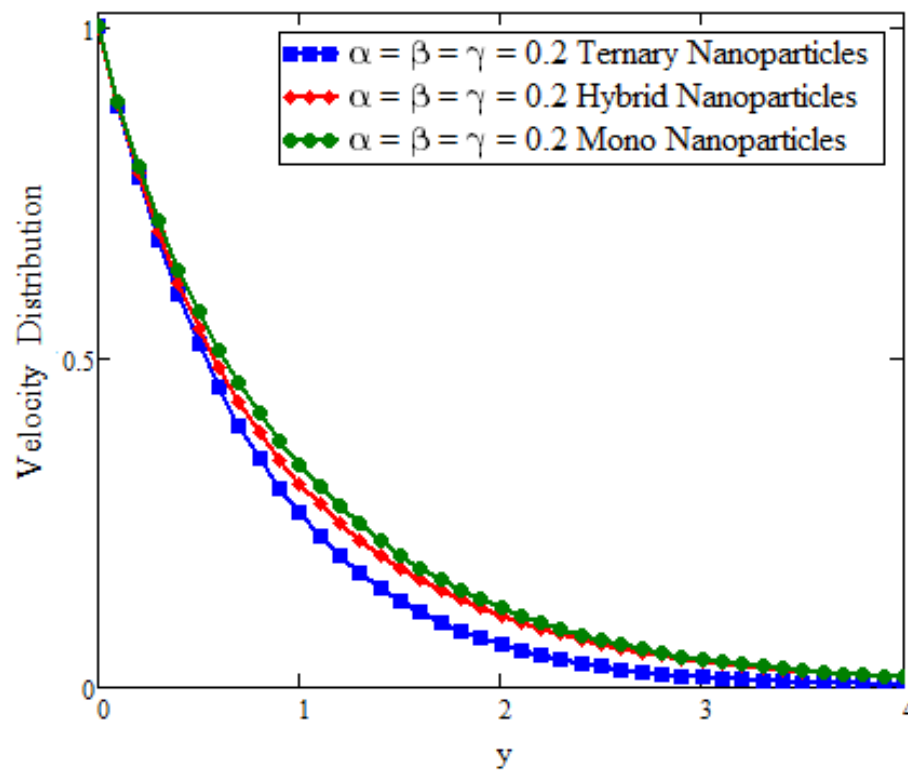
Figure 5. Comparison of velocity assessment with α β γ across y as Sc = 9.2 when t = 1, α = β = γ = 0.2, M = 1.5, and Pr =